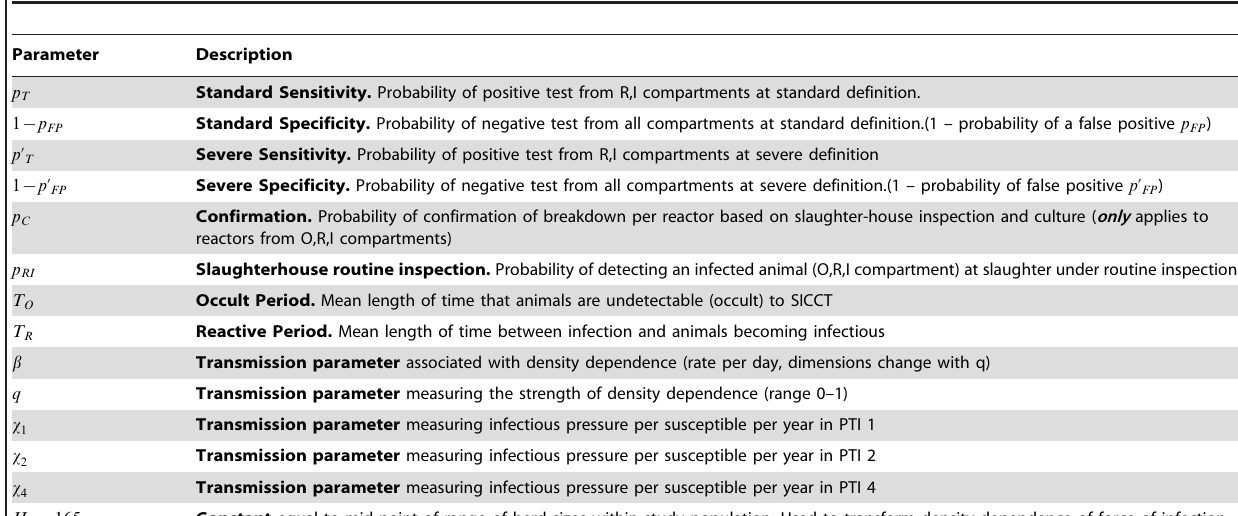
Table 1. Model parameters.